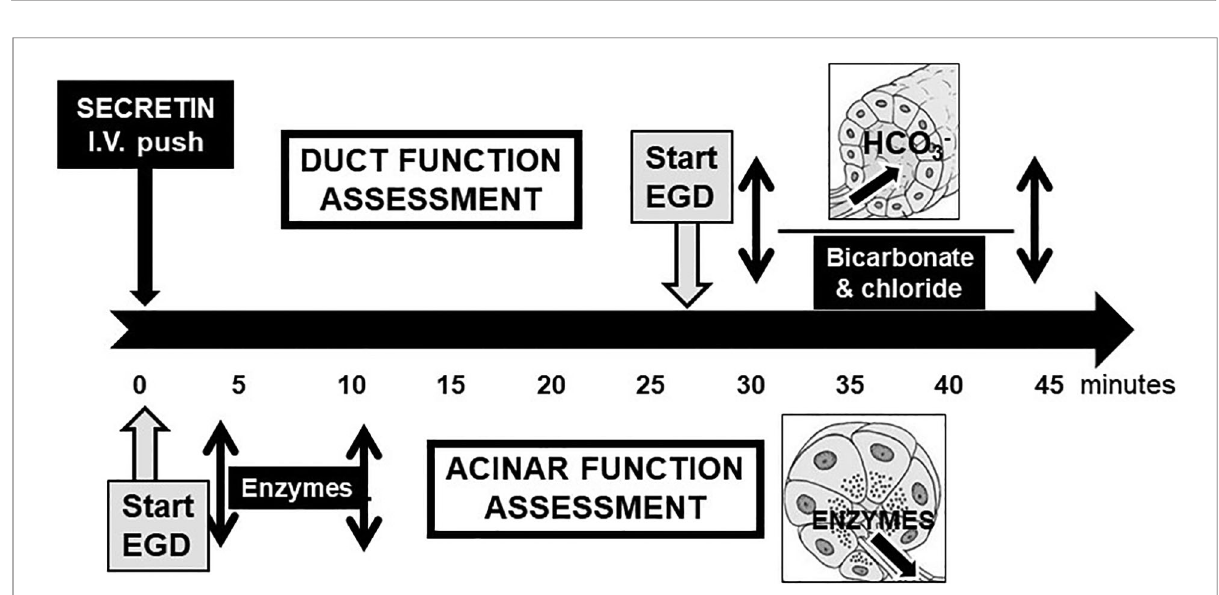
FIGURE 2 Ductal function assessment with bicarbonate concentration from prolonged ePFT with fl uid collection up to 45 min. ( A ) Normal tests with the bicarbonate concentration is above 80 mmol/L. ( B ) Abnormal tests in patients with genetic abnormalities in three patients when the bicarbonate never reached the 80 mmol/L [adapted from Horvath, K. et al. (125)].